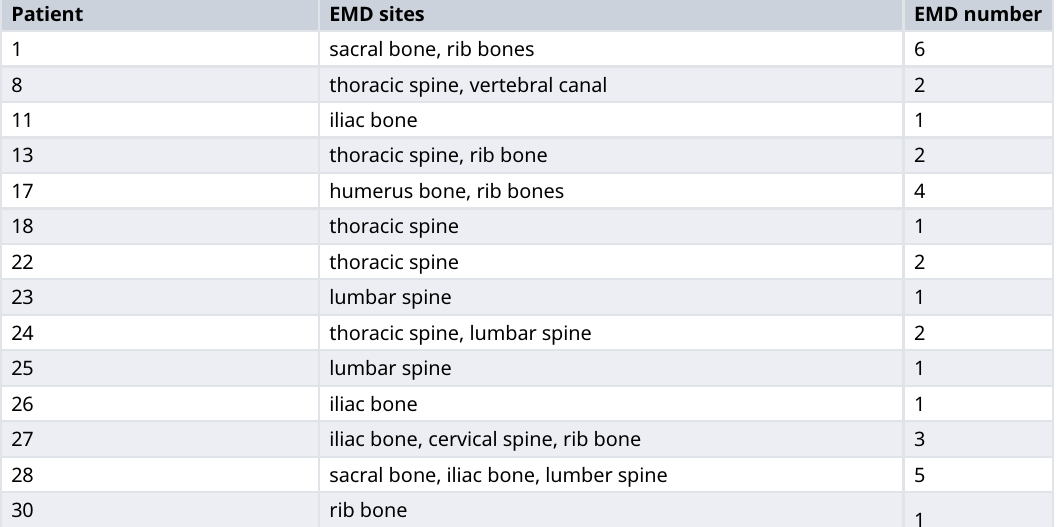
Table 2. The EMD sites involved and the number of EMD sites per patient at initial